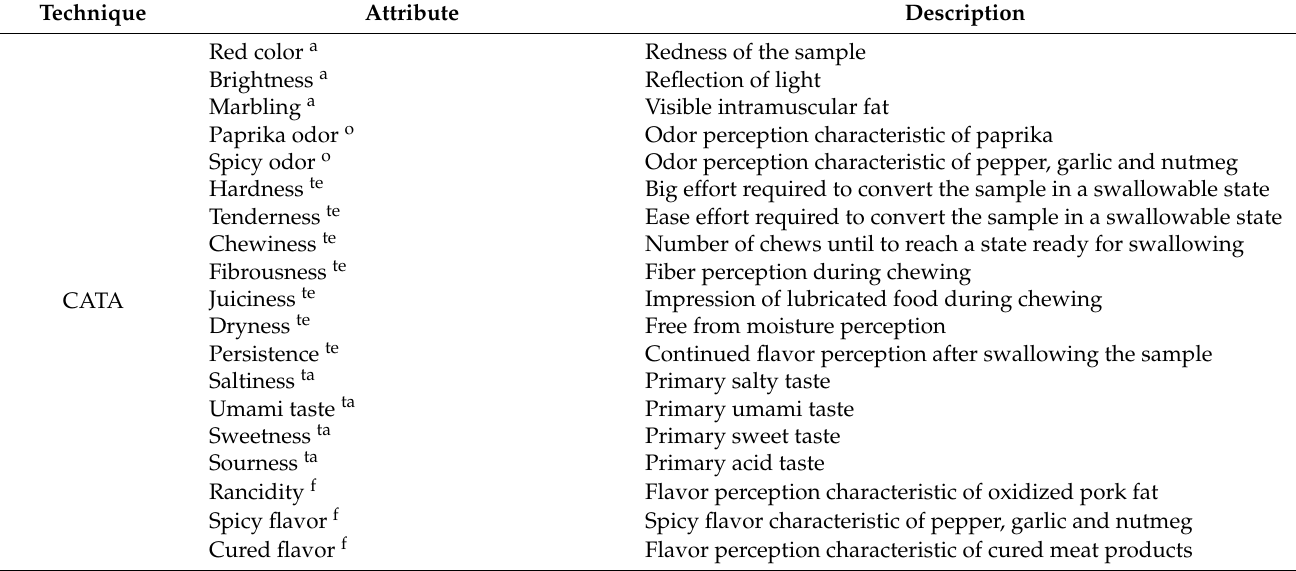
Table 1. Attributes and descriptions used on CATA and multiple-intake TDS